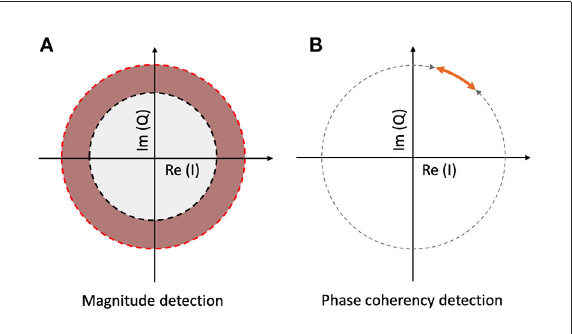
FIGURE2 Signal detection methods with spectrum and coherency at a particular temporal frequency. (A) The spectral power is significantly elevated, when the vector reaches the red annulus. The noise threshold is set by the radius of the gray circle. (B) The signal is phase-locked to the stimulus, when the normalized vector’s angle is inside the orange interval. The noise threshold is determined by the gray